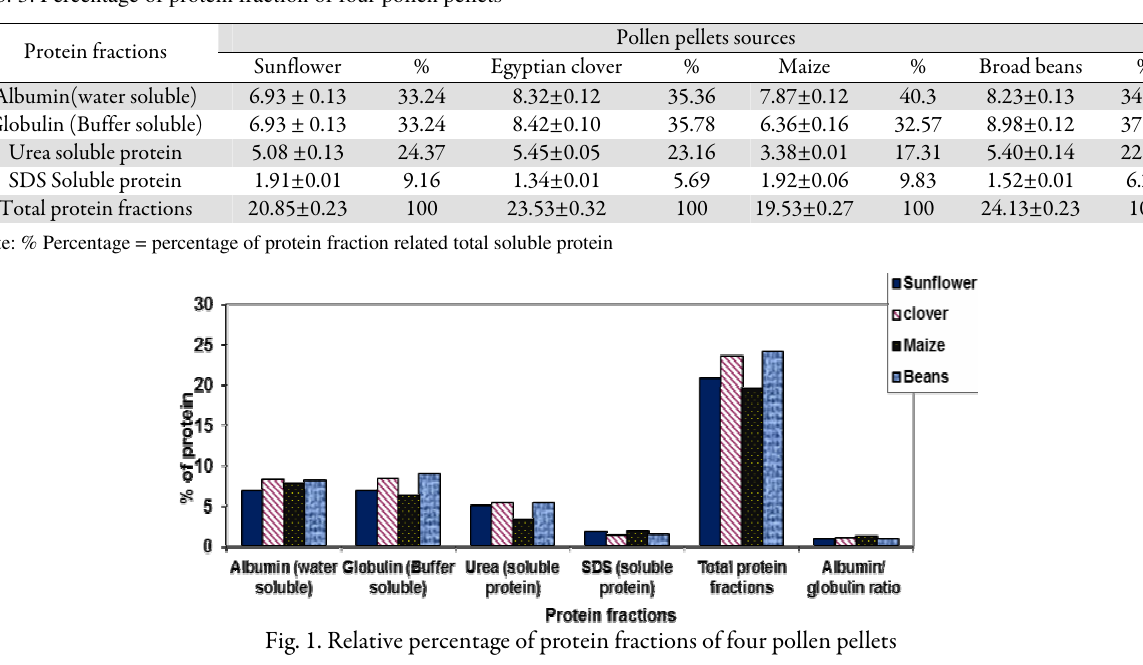
Tab. 3. Percentage of protein fraction of four pollen pellets